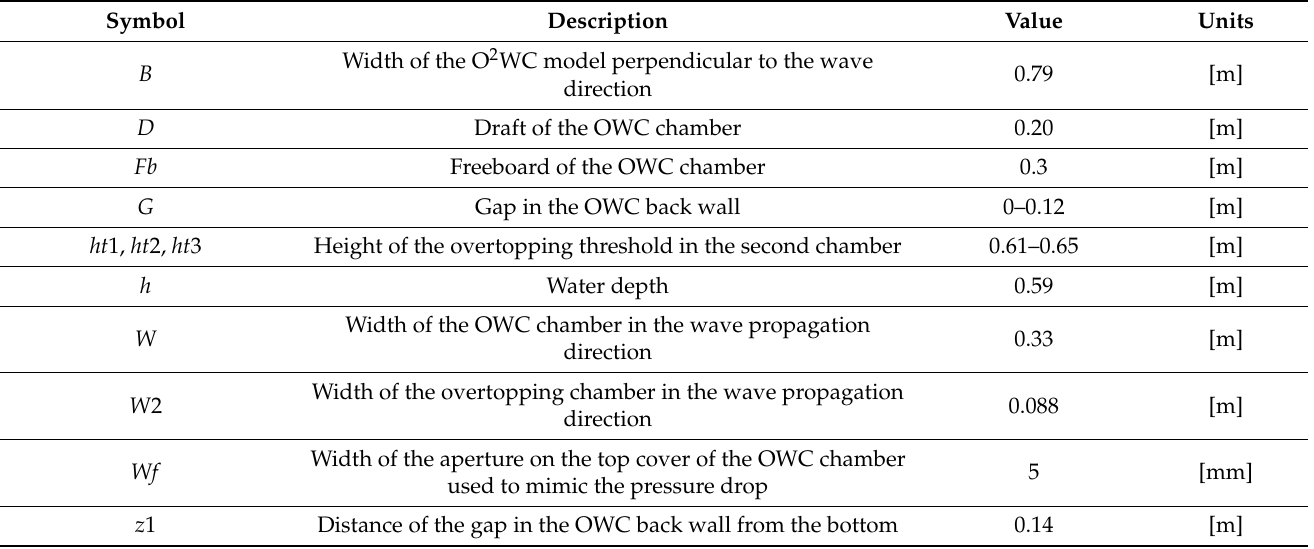
Table 1. Parameters of the O 2 WC model (values at laboratory scale